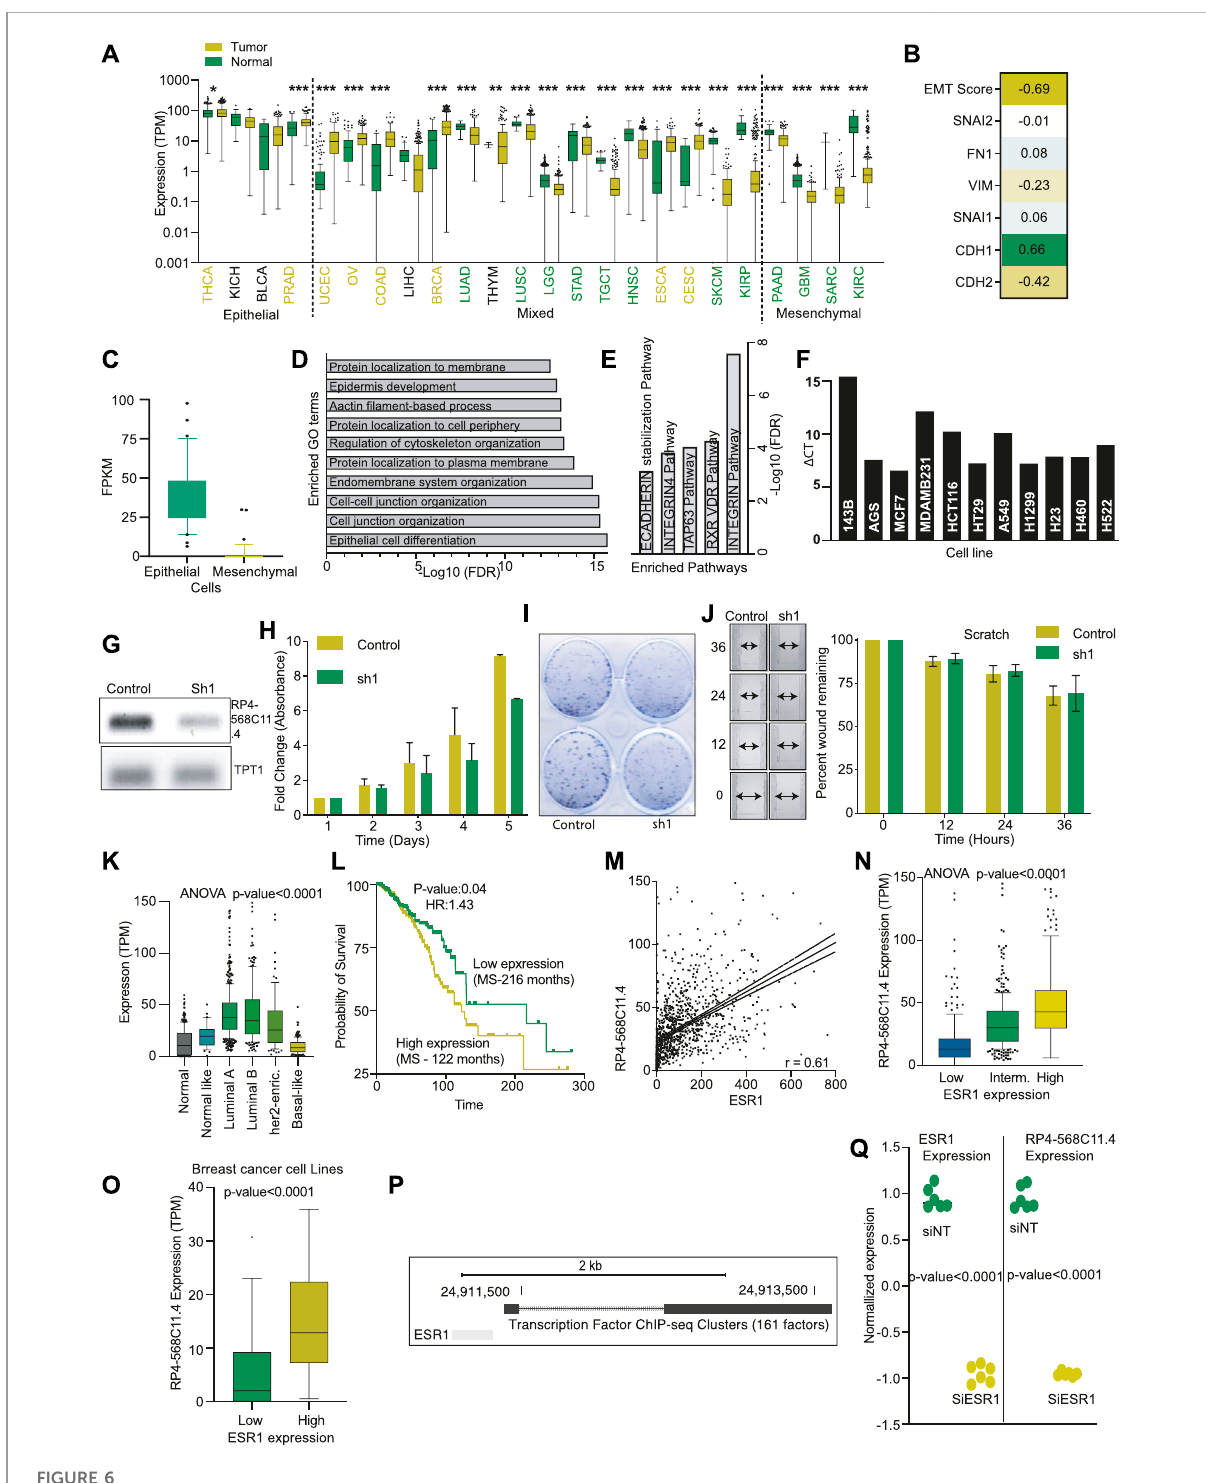
RP4-568C11.4 is an epithelial cancer gene and regulates cell proliferation. (A) Expression of RP4-568C11.4 was compared in all the TCGA cancer types corresponding normal and plotted. Yellow: Overexpressed in cancer, Green: Unexpressed in cancer, Black: No signi fi cant difference. (B) Correlation between RP4-568C11.4 and EMT markers was performed, and coef fi cients are represented as a heatmap. (C) Expression of RP4- 658C11.4 in epithelial and mesenchymal cells. (D) Enriched GO terms and (E) Pathways identi fi ed using gene correlated with RP4- 568C11.4 expression. (F) Expression of RP4-568C11.4 as identi fi ed by semi-quantitative PCR. (G) Expression of RP4-568C11.4 after knockdown in MCF7 cells. (H) Effect of RP4-568C11.4 knockdown on (H) Proliferation (I) Colony formation ability of MCF7 cells. (J) Effect of